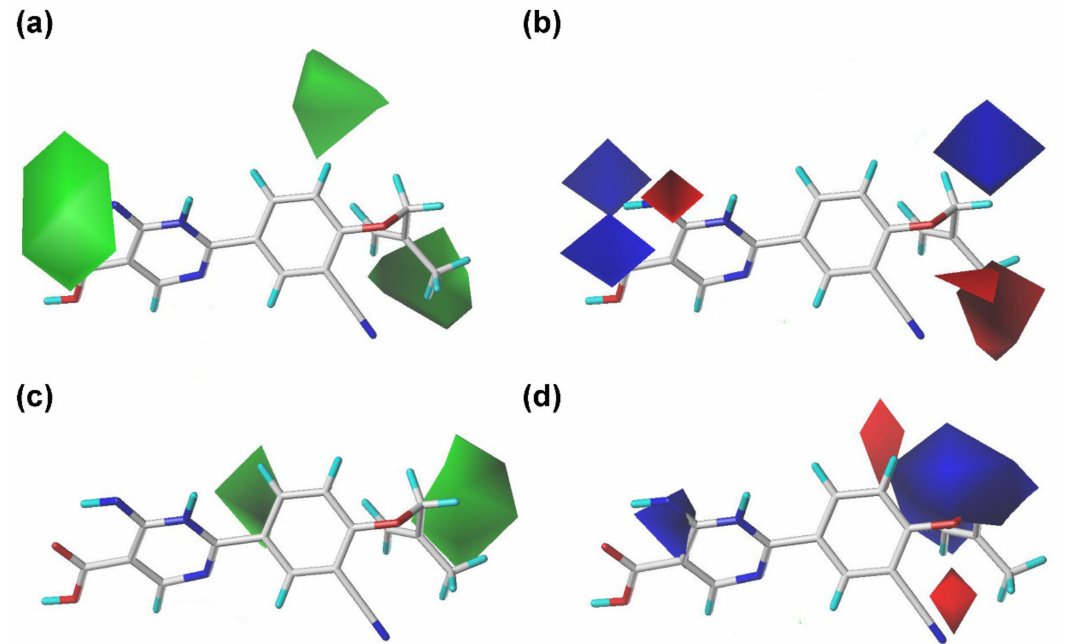
Figure 3. Contour maps of the CoMFA and CoMSIA-SEHDA models using compound 44 as a reference. ( a ) The steric contours of the CoMFA model. ( b ) The electrostatic contours of the CoMFA model. ( c ) The steric contours of the CoMSIA model. ( d ) The electrostatic contours of the CoMSIA